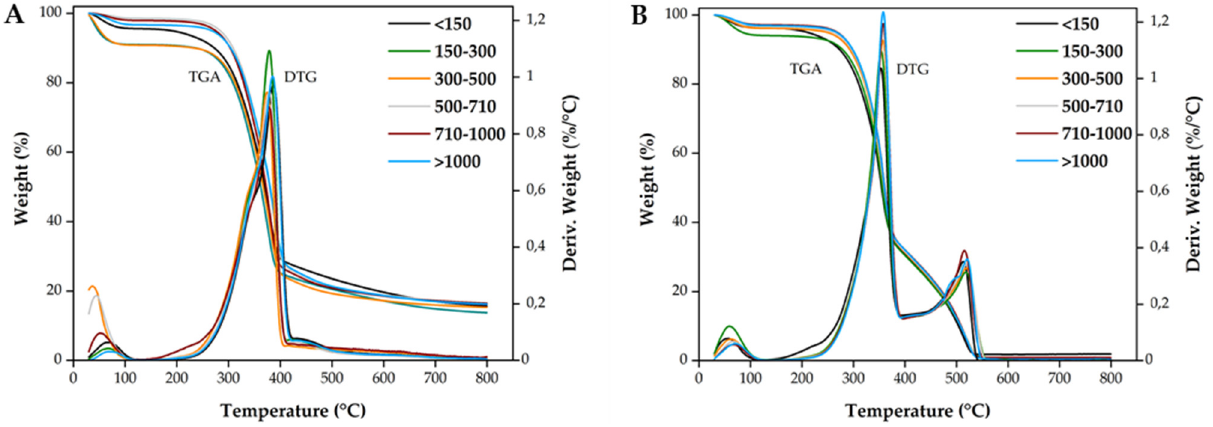
Figure 4. Thermal analysis (TGA) and derivative thermogravimetric analysis (DTG) curves of wood sawdust with different granulometries under: ( A ) nitrogen and ( B ) artificial air atmosphere. Table 2. Summary of TGA data for each wood granulometry.